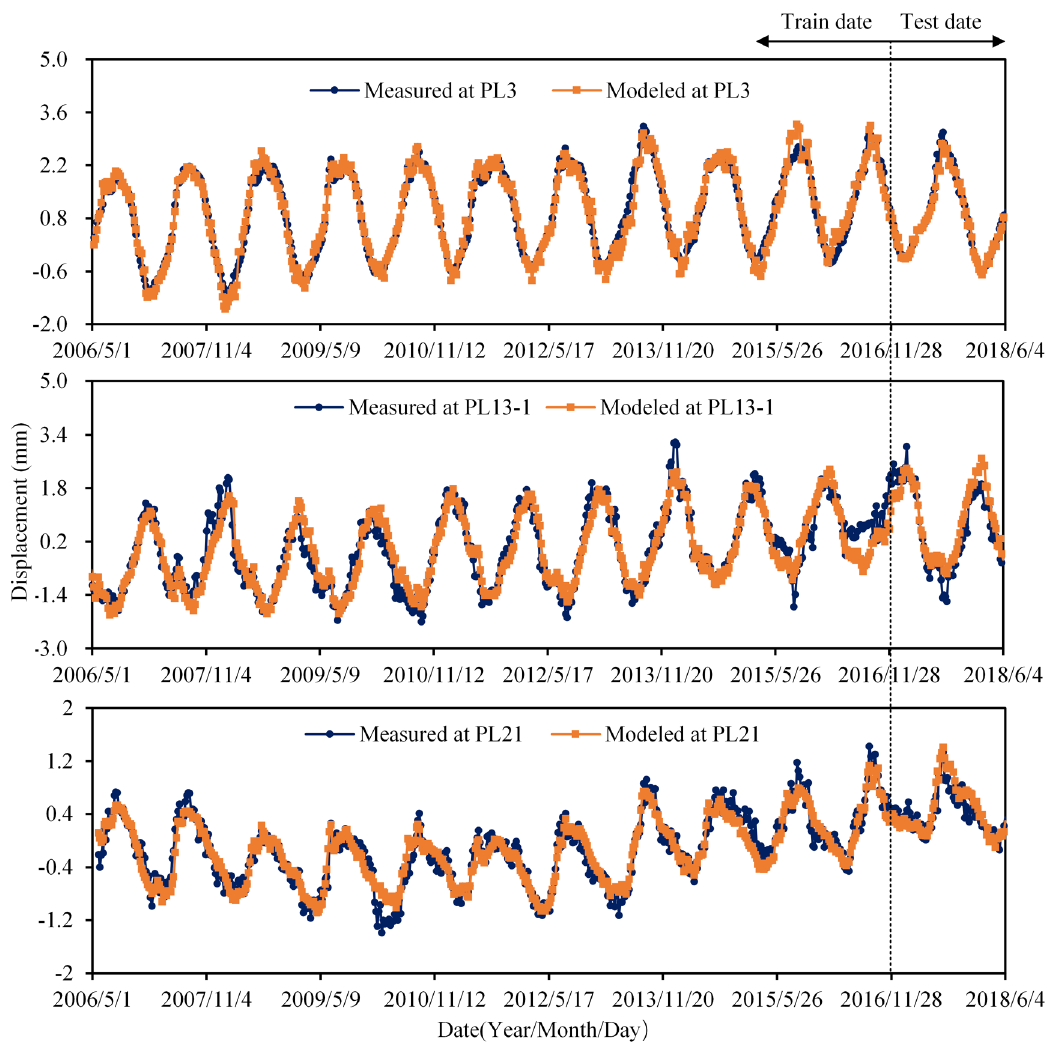
Figure 12. Monitoring date, MLSR model results for radial displacements at PL3, PL13-1 and